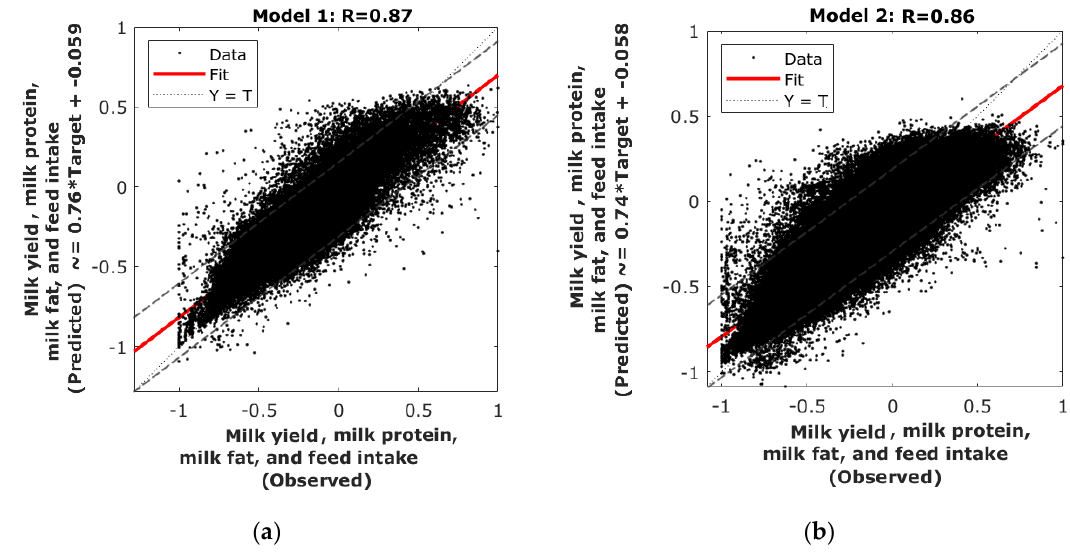
Figure 3. Overall regression graphs of ( a ) Model 1: Using the 36 cows with similar heat tolerance (93–